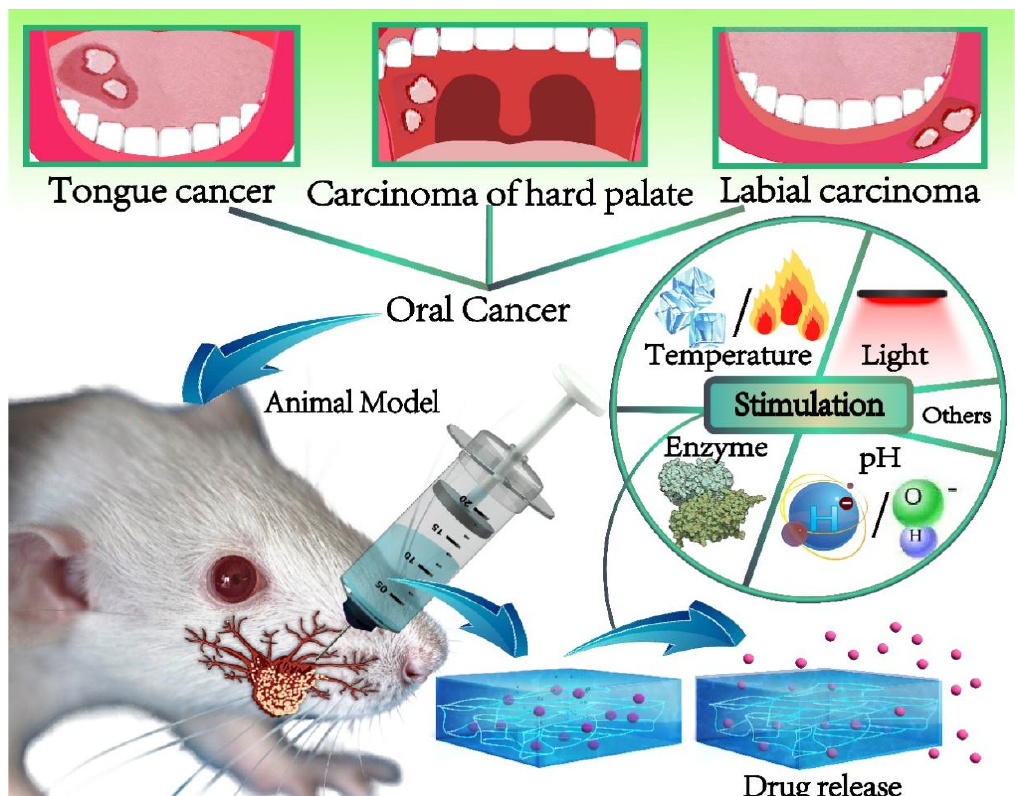
Figure 1. The smart hydrogel-based drug delivery system for oral cancer therapy.